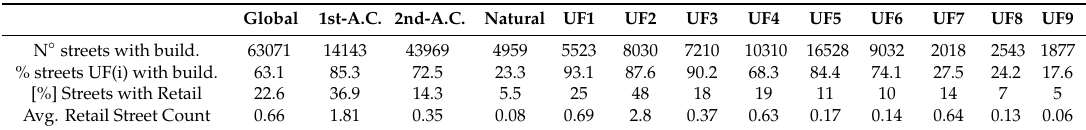
Table 1. Micro-retail distribution, variance and zero-inflation values for the overall study region and within each morphological